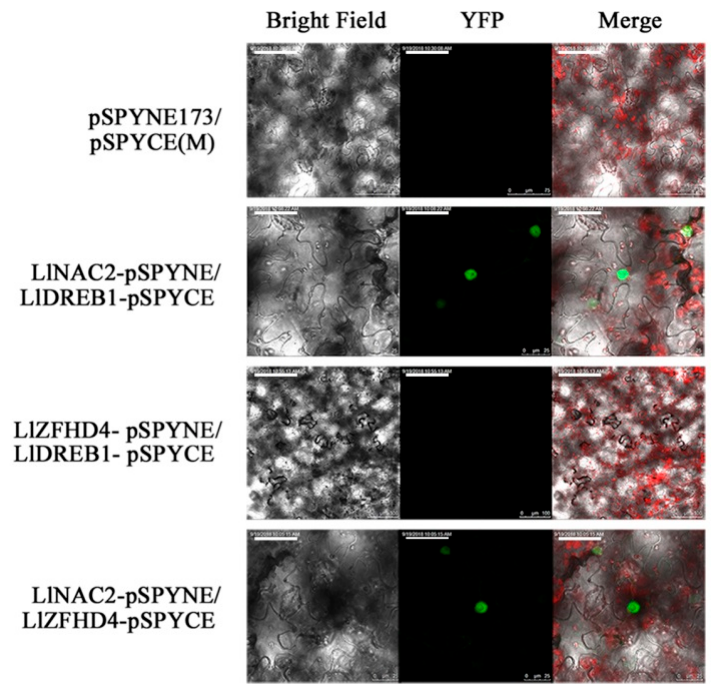
Figure 6. Bimolecular fluorescence complementation assay using tobacco epidermal cells. Negative controls were pSPYNE173 / pSPYCE (M) and LlZFHD4-pSPYNE / LlDREB1-pSPYCE. Scale bars for LlZFHD4-pSPYNE / LlDREB1-pSPYCE, 100 µ m; for others, 25 µ m.